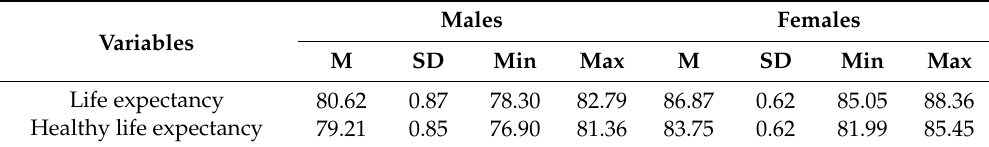
Table 1. Descriptive statistics for life expectancy and healthy life expectancy (years) at birth. Variables